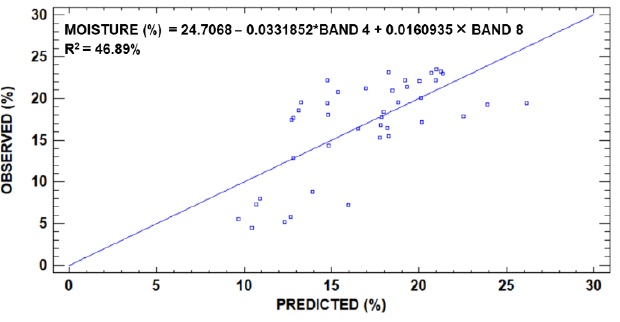
Figure 5. Multiple Regression Models for clay soil for bands with 10 m of resolution.